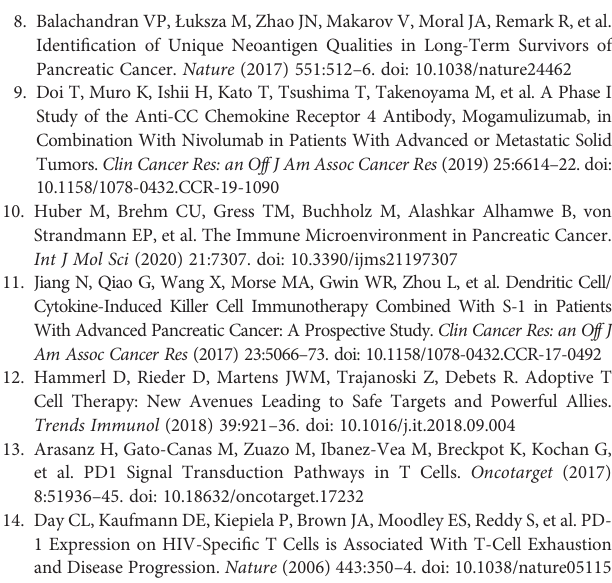
Supplementary Figure 1 | Survival analysis of subgroups divided by the expression of PD-L1 in the tumor tissues. Supplementary Figure 2 | Cox proportional hazards analysis to identify the signi fi cant prognostic factors for OS (A) and PFS (B)